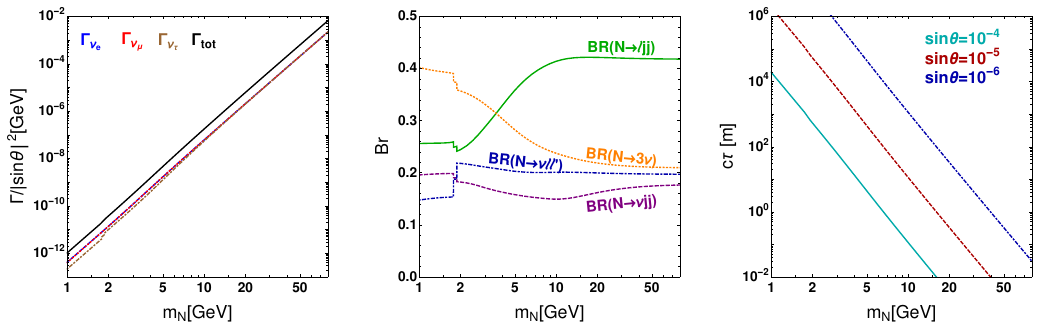
Figure 1 . The decay partial widths, branching ratios and lifetime for heavy sterile neutrino N , under a democratic mixing assumption sin (cid:18) (cid:23) we show the partial decay width from mixing with (cid:23) e , (cid:23) (cid:22) , (cid:23) (cid:28) and total decay width respectively. In the middle panel, we show the branching ratios to leptonic channels (cid:23)‘‘ 0 , (cid:23)(cid:23)(cid:23) and semi-leptonic channels ‘jj and (cid:23)jj . In the right panel, we show the lifetime as a function of m N with benchmark mixing angle sin (cid:18) = 10 (cid:0) 4 , 10 (cid:0) 5 and 10 (cid:0) 6